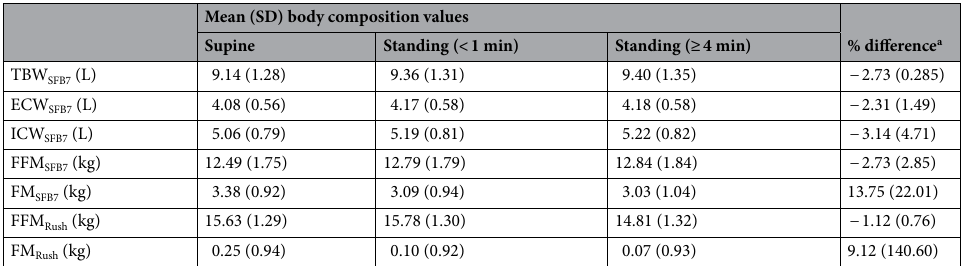
Table 3. Mean body composition values when the participants were measured supine and standing (< 1 min and ≥ 4 min). a Percentage difference between mean supine and standing (≥ 4 min) body composition values. FFM SFB7 fat-free mass from ImpediMed SFB7 built-in equation, FM SFB7 fat mass from ImpediMed SFB7 built-in equation, FFM Rush fat-free mass from Rush et al. 2013 equation, FM Rush fat mass from Rush et al. 21